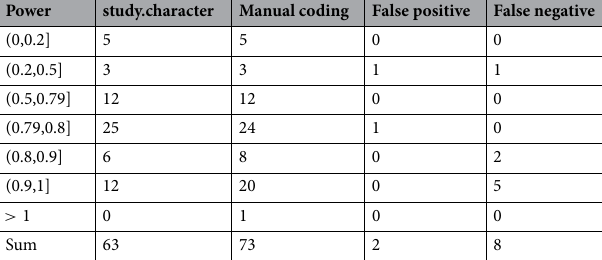
Table 6. Absolute frequencies of extracted categorized test